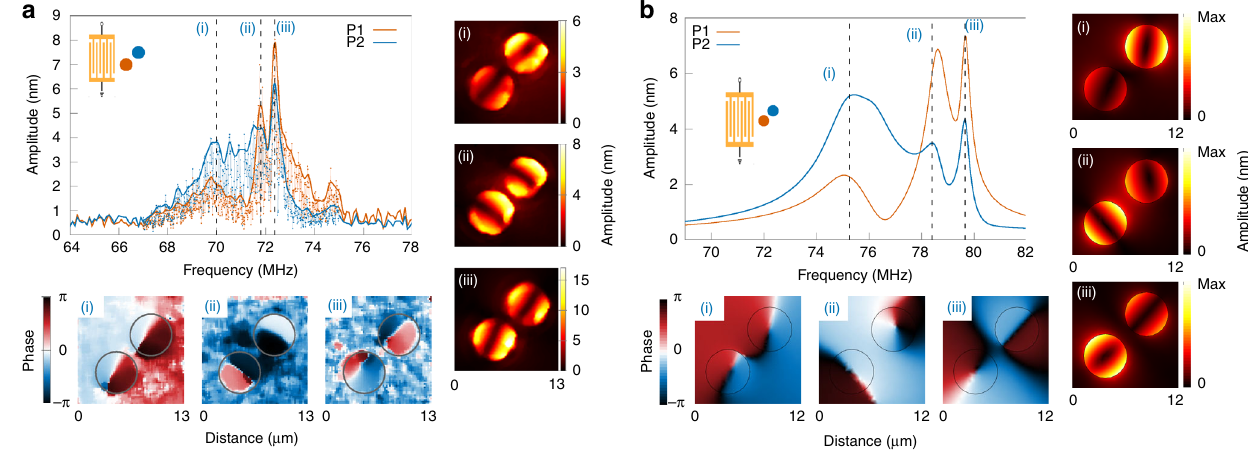
Fig. 2 Diagonal incidence. a Left: experimental frequency responses of the 1.5 µ m-spaced pillars of the pair in the 45° con fi guration. Right: out-of-plane displacement fi eld maps on the pillar surface for typical excitation frequencies: 69.99 MHz (i), 71.81 MHz (ii) and 72.37 MHz (iii). Bottom: corresponding phase maps on the top of the pillars. The scan area is 13 µ m × 13 µ m, with a step size of 200 nm. b Left: simulated frequency responses of 1.5 µ m-spaced pillars of the pair in the 45° con fi guration, obtained by extracting the maximum out-of-plane amplitude on top of each pillar. Right and bottom: corresponding displacement maps (| u z | and arg( u z ), respectively) for typical resonance frequencies: 75.25 MHz (i), 78.40 MHz (ii) and 79.65 MHz (iii). The dimensions of the maps are 12 µ m × 12 µ m